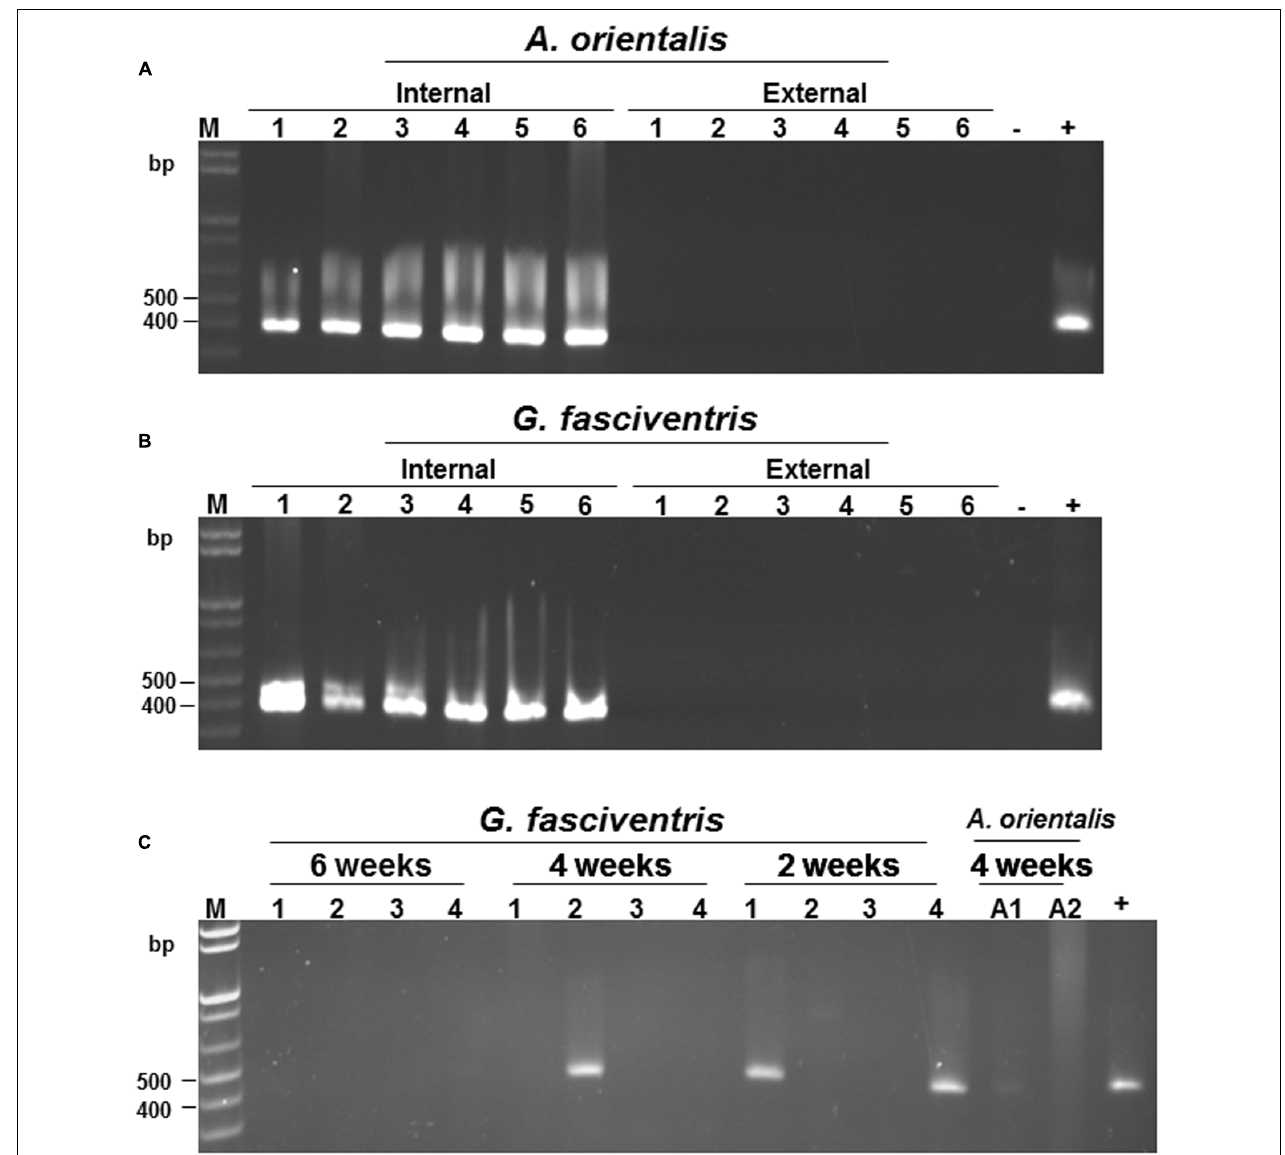
FIGURE 4 | Verification of the internal localization of BaMV in the dipterans. Following feeding with BaMV-containing medium for 24 h and virus-free medium for 72 h, the presence of BaMV RNA on the external surfaces (lanes labeled “External”) and within insect bodies (lanes labeled “Internal”) of individual A. orientalis (A) and G. fasciventris (B) flies were assayed by RT-PCR as described above. RT-PCR products using nucleic acids extracted from insects fed on healthy bamboo plants or BaMV-containing medium (1 µ l) as the templates were used as negative (lanes − ) and positive controls (lanes +), respectively. (C) Detection of the retention of BaMV within dipteran insects by RT-PCR. The presence of BaMV RNA within G. fasciventris samples fed with GFP-tagged BaMV was examined at two-week intervals (indicated on top of the lanes) by RT-PCR as described above (four insects per group). Lanes A1 and A2, A. orientalis samples collected at 4 weeks post BaMV-feeding; lane M, size marker, lane +, positive